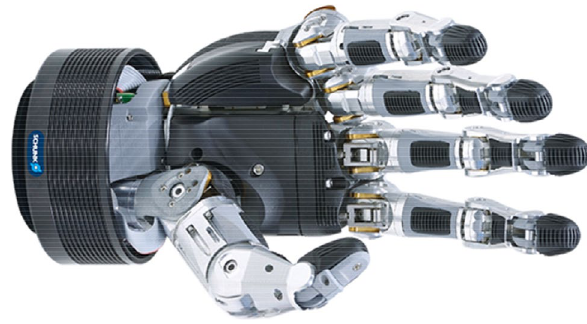
Fig. 4 SVH anthropomorphic gripper [13]